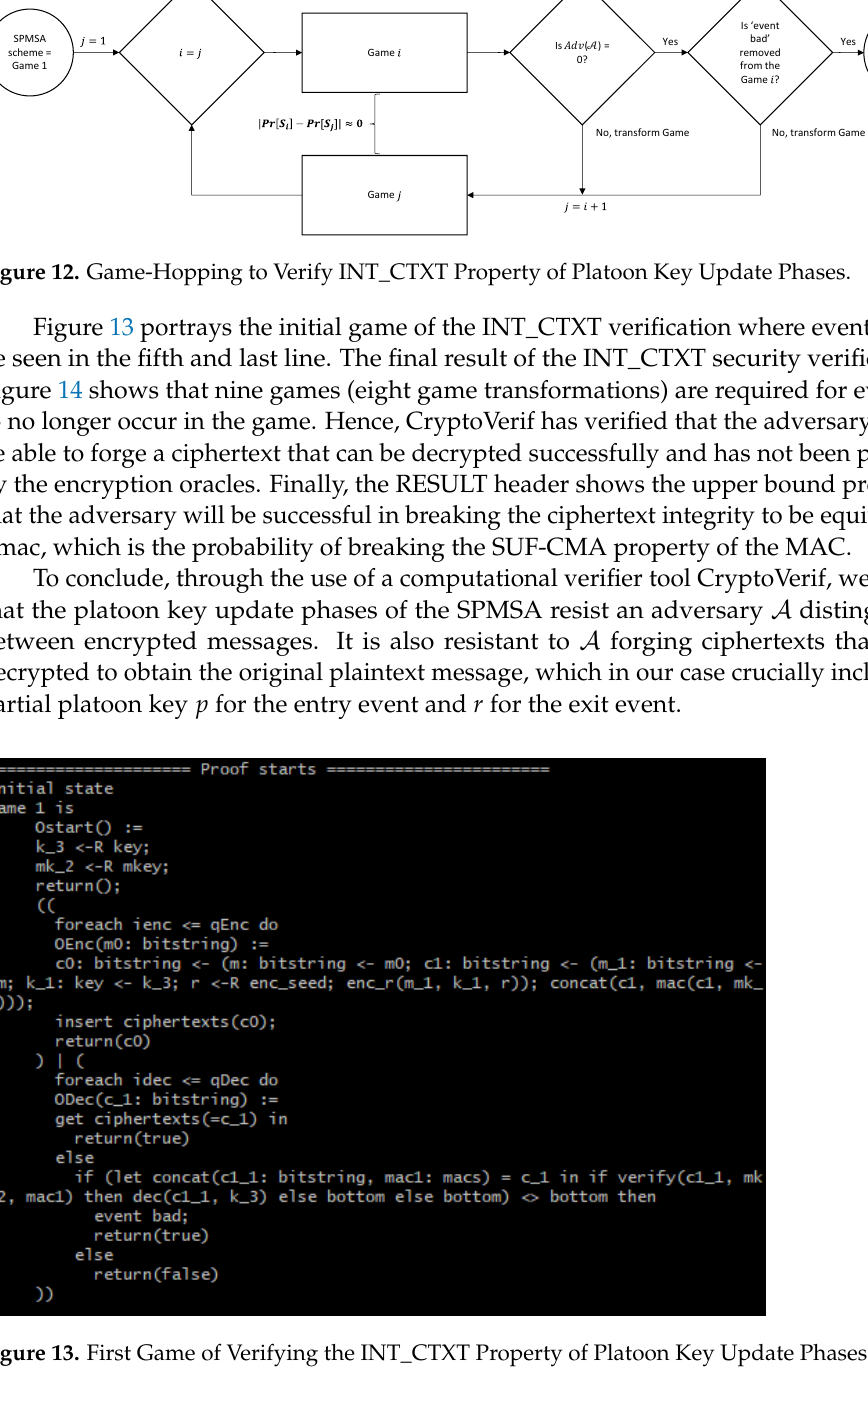
Figure 13. First Game of Verifying the INT_CTXT Property of Platoon Key Update Phases.